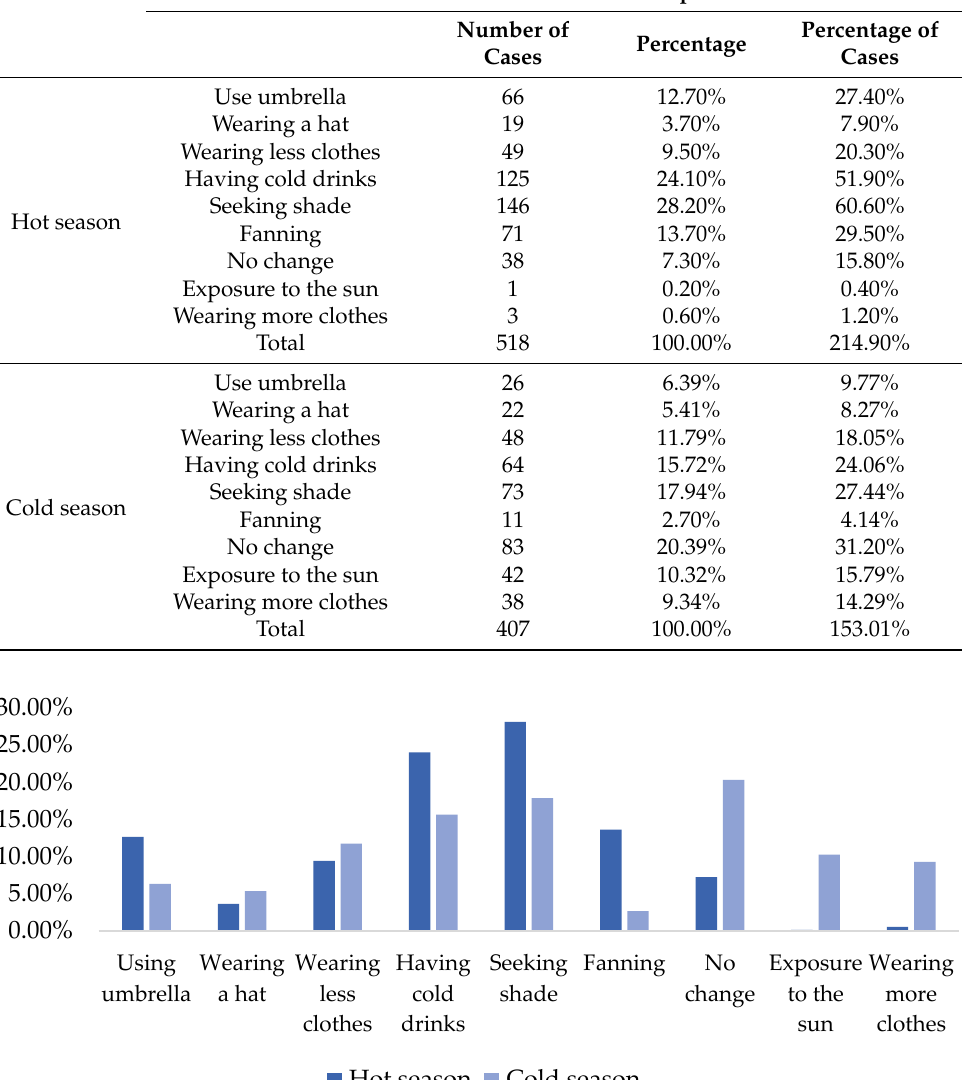
Figure 13. Adaptive behavior statistics.